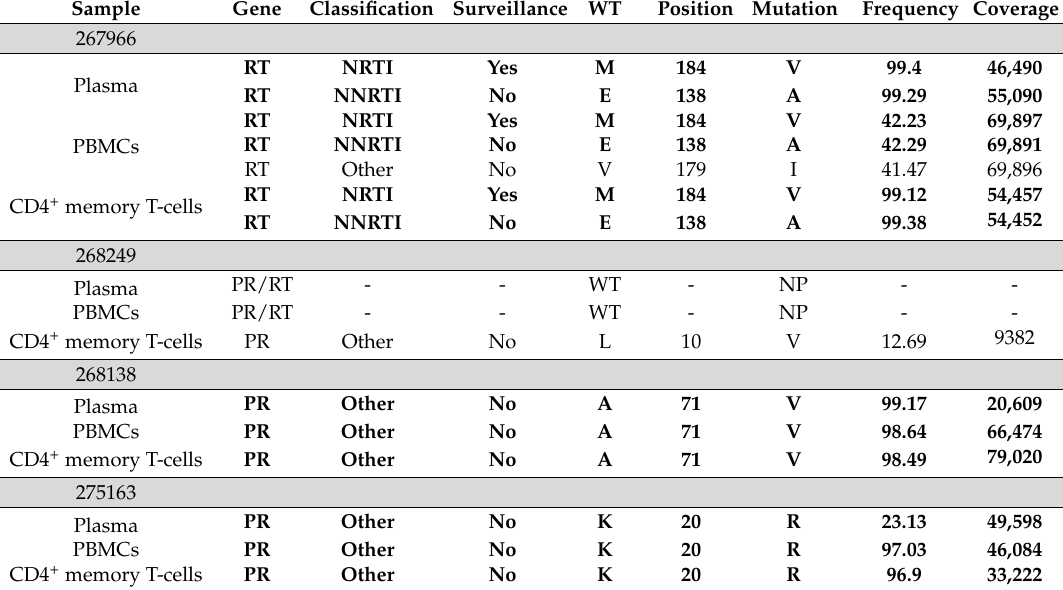
Table 3. Mutations detected by Next-Generation Sequencing. The threshold for data analysis was set at 5%. Protease and RT genes were analyzed and the table includes the gene and compartment with drug resistance mutations detected at the 5% threshold. NP indicates that high frequency mutations were not present in the samples analyzed. Letters in bold indicate drug resistance mutations that were also detected by Sanger sequencing. (-) indicates not applicable.